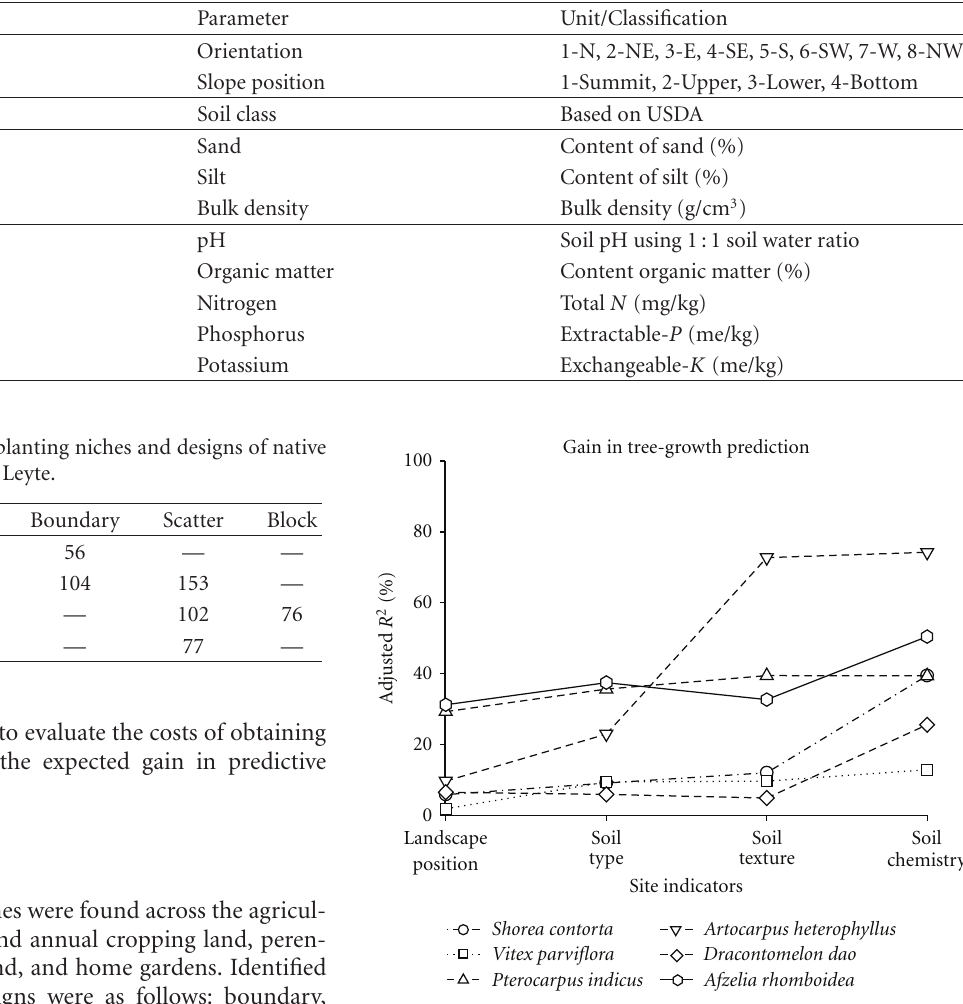
Figure 4: Stepwise gain in treegrowth prediction based on a set of simple site